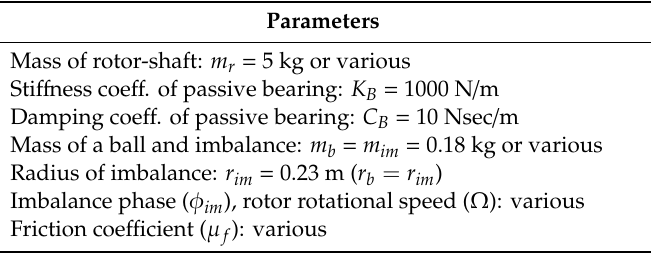
Table 1. System parameters for numerical simulation. Parameters